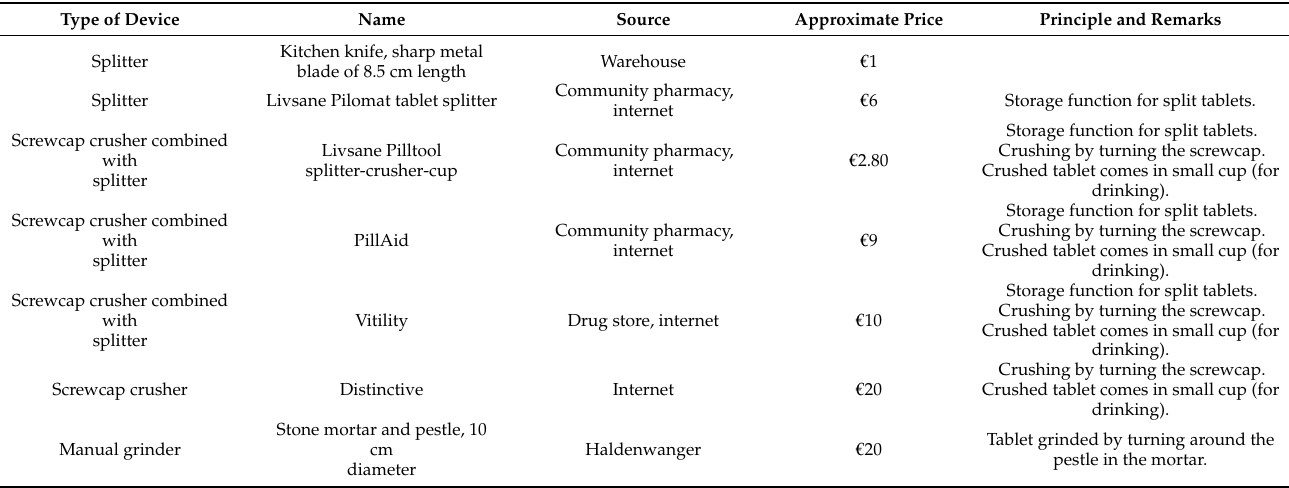
Table 1. Overview of devices used for splitting, crushing, and grinding tablets. Type of device, brand name, source from which it can be purchased, and approximate price are given as well as the principle of operation and additional remarks (if